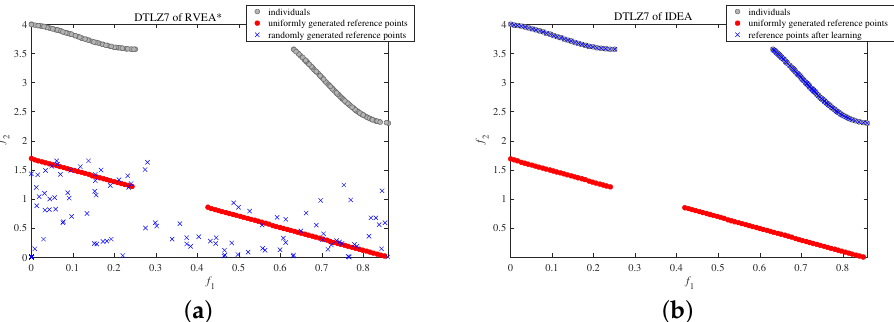
Figure 2. Illustration of reference point adaptive adjustment. ( a ) RVEA*. ( b )